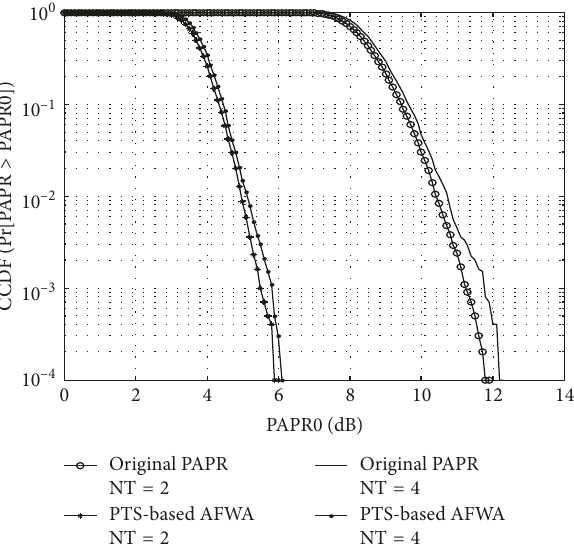
Figure 6: PAPR reduction performances in MIMO-OFDM-based WiMAX standard. Table 2: Computational complexity of the different PTS schemes